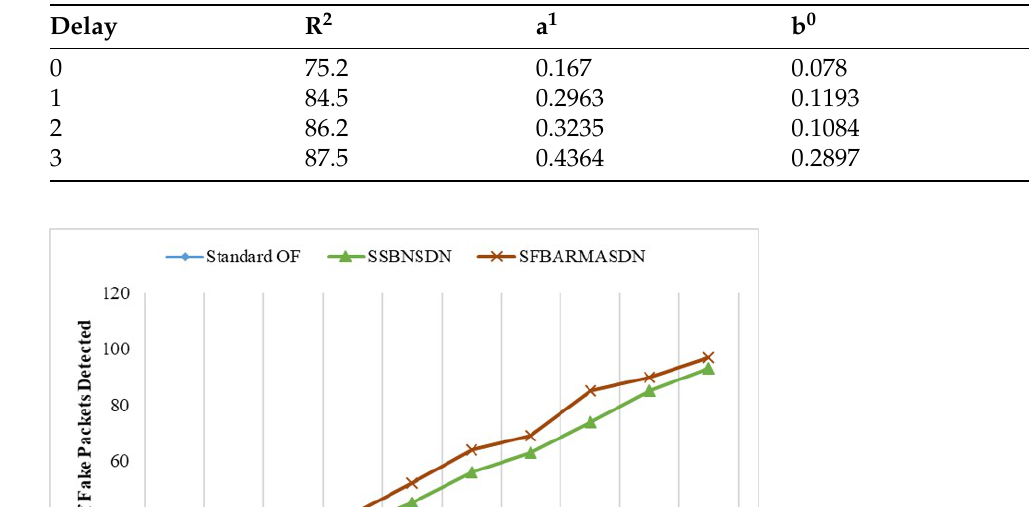
Table 1. Models coefficient and fits for W(z) transfer function.